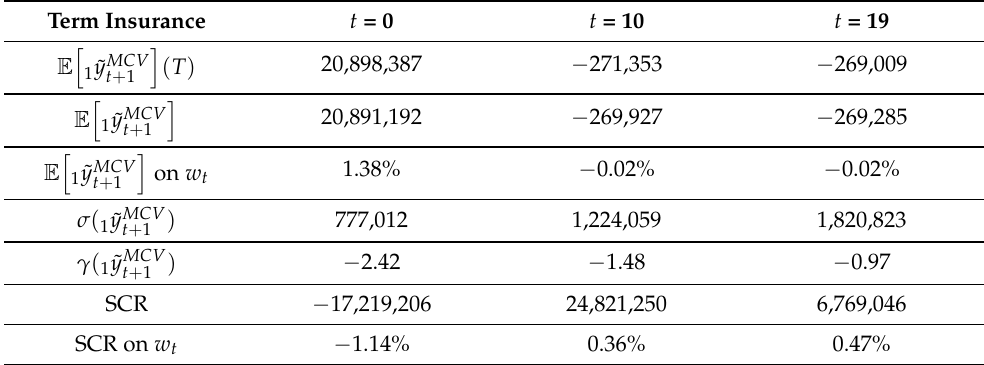
Table 8. Simulated MCV results - Term Insurance.